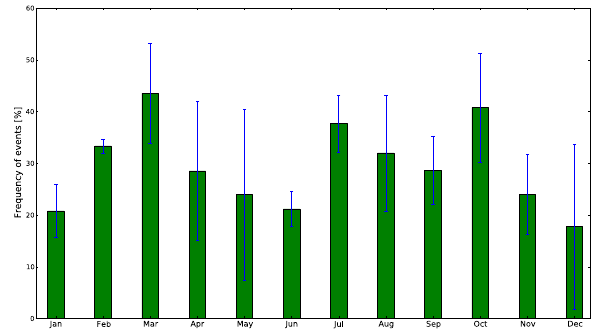
Fig. 3. Monthly mean nucleation frequencies at the puy de Dˆome